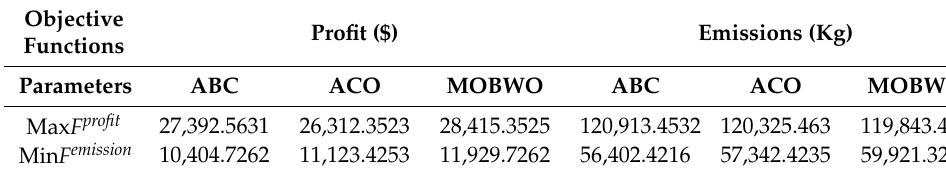
Table 11. The pay-off table for the proposed MOBWO (15-min scheduling).